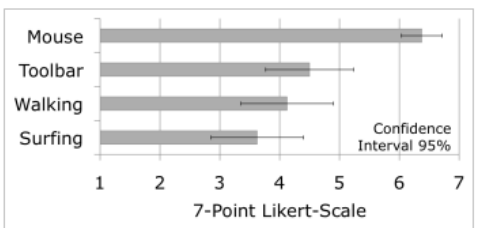
Figure 11. Overall satisfaction (1=strongly unsatisfied, 7=strongly